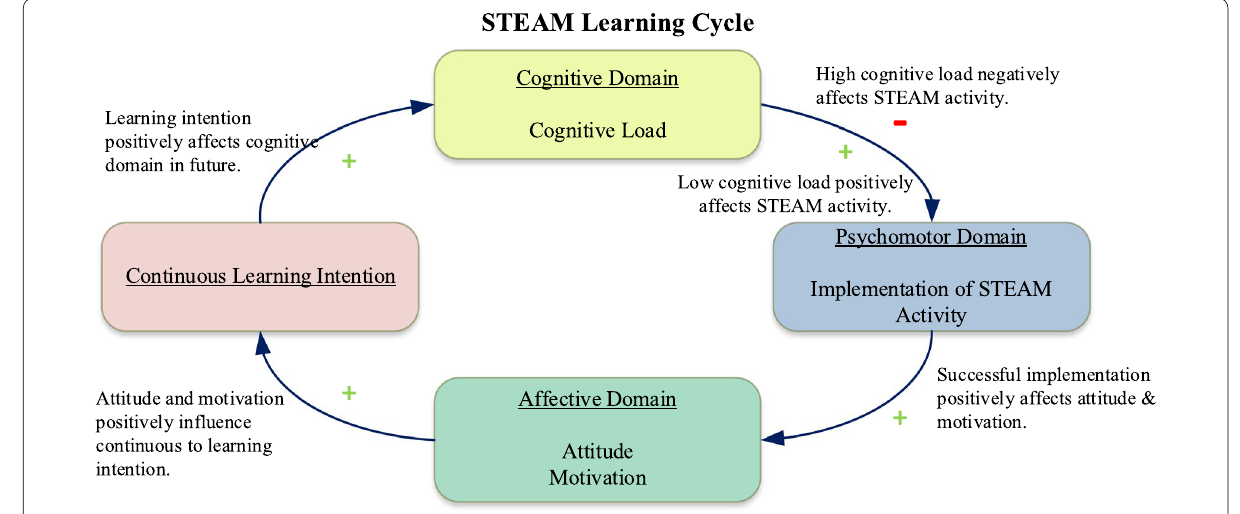
Fig. 1 STEAM learning